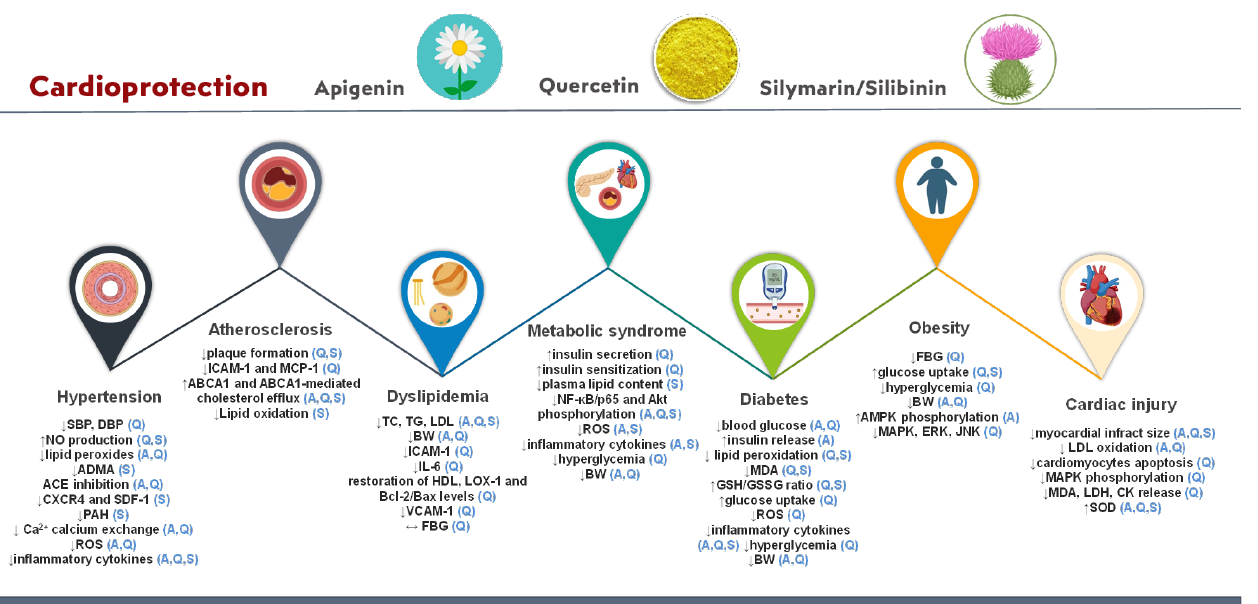
Figure 3. Schematic representation of the most important cardiovascular protective properties of apigenin, quercetin, and silymarin/silibinin as well as the related possible mechanisms of action. Arrows indicate increase ( ↑ ), decrease ( ↓ ), and non-significant changes ( ↔ ) in the respective biomarker expression or effect (figure animation was generated using the BioRender.com (accessed on 22 December 2022). A. apigenin; Q. quercetin; S. silibinin/silymarin .